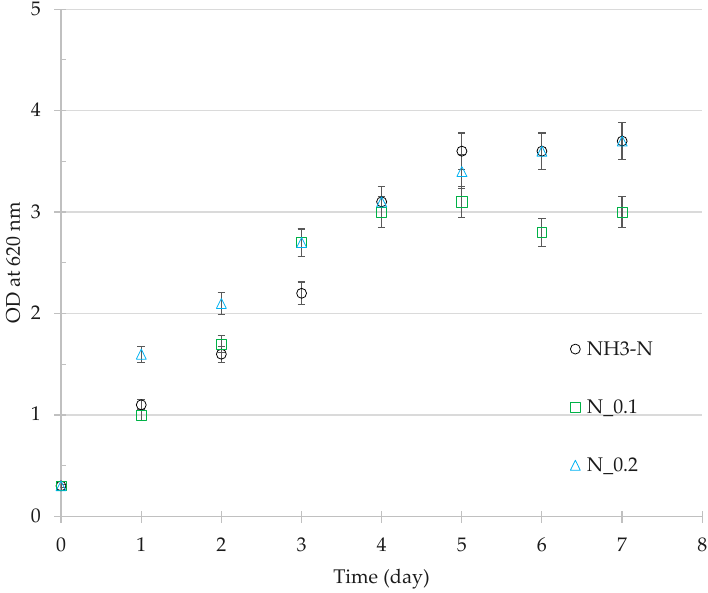
Figure 7. Chemolithotrophic growth of C. necator with ammonium nitrogen (NH 3– N) and residual cell mass nitrogen (N_0.1, N_0.2). Average ODs of duplicated bottle cultures are presented.